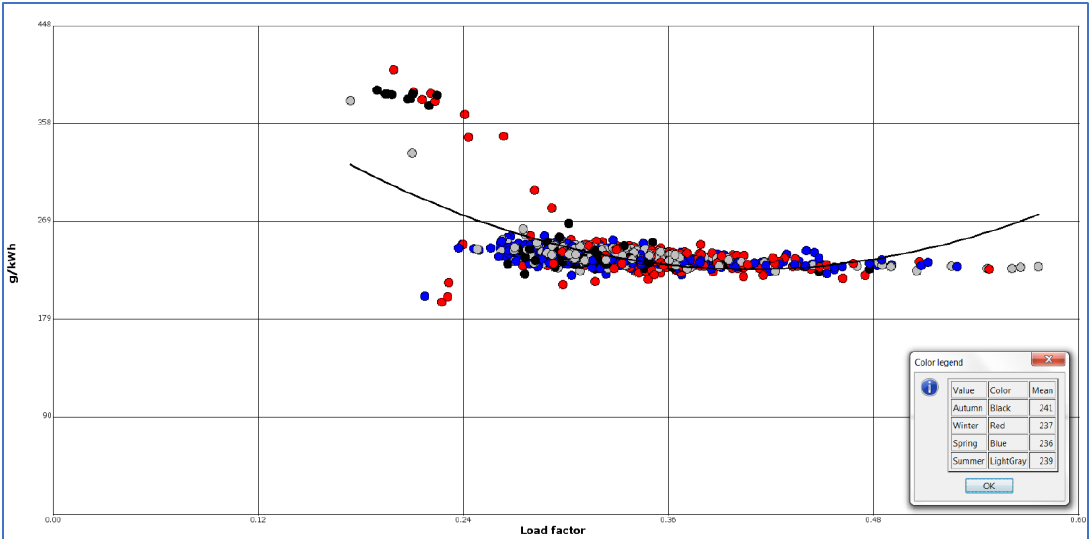
Figure 9. Specific fuel oil consumption (g/kWh) vs. load factor (actual power over installed power) from Finnmarken. The gray line is a fitted second-degree polynomial trend line.